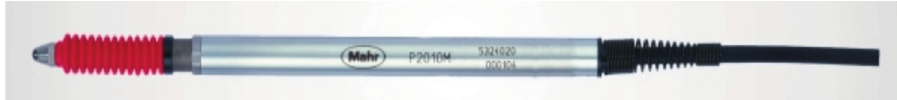
Figure 9: Mahr-P2010M axial inductive displacement sensor.